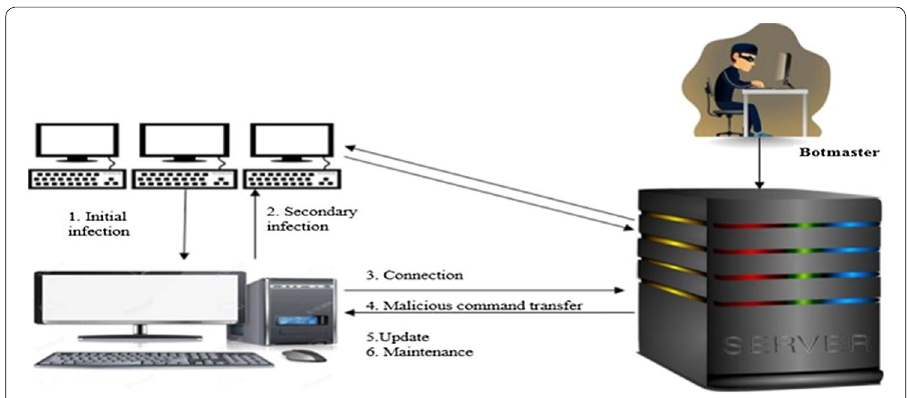
Fig. 1 An example of botnet